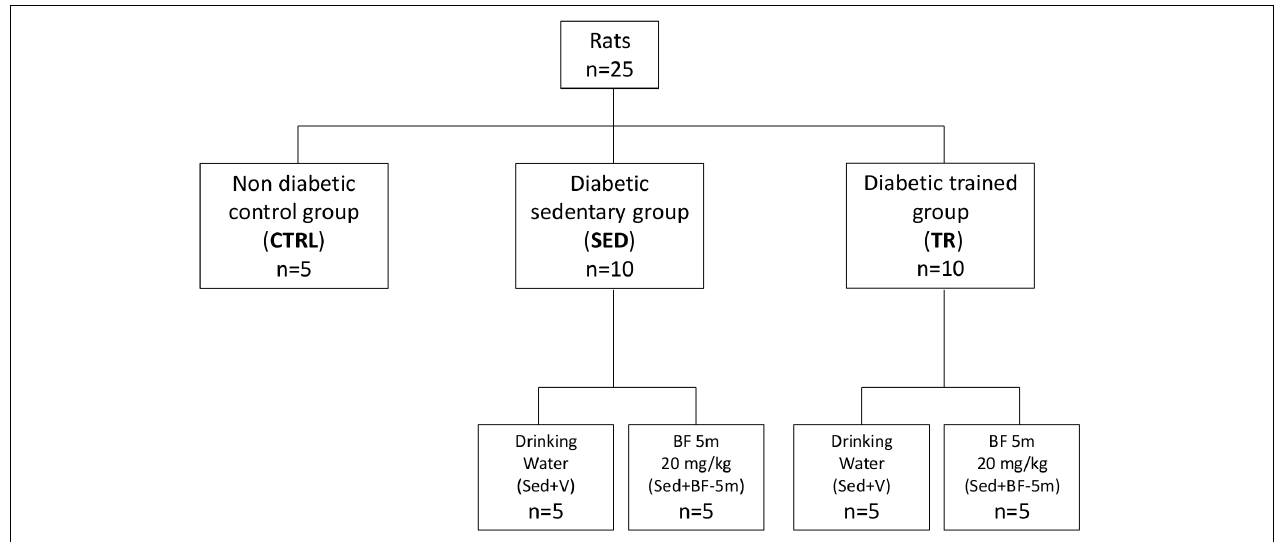
FIGURE 1 | Flow chart showing the experimental design. CTRL, healthy control rats; Sed+V, diabetic sedentary rats treated with vehicle; Sed+BF-5m, diabetic sedentary rats treated with BF-5m 20 mg/kg/day; Tr+V, diabetic trained rats treated with vehicle; Tr+BF-5m, diabetic trained rats treated with BF-5m 20 mg/kg/day.